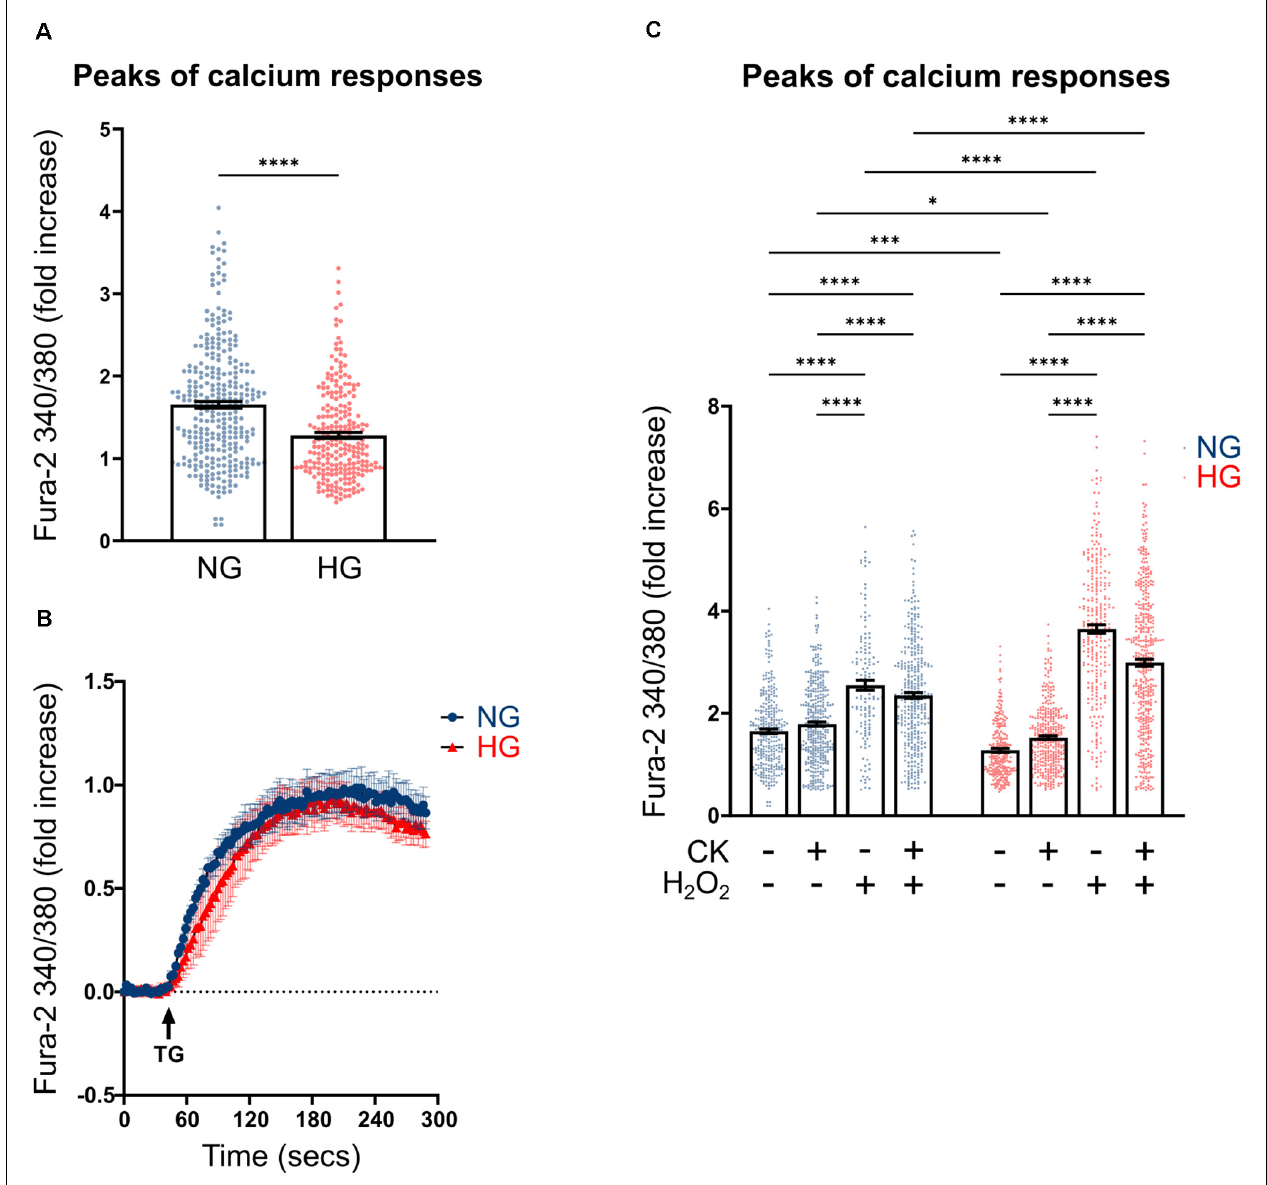
FIGURE 4 | Effect of CK treatment and oxidative stress on ATP-mediated calcium responses. (A) Scatter graph with bars represents the peaks of calcium response following ATP acute stimulation. Each dot represents the maximum peak of a single rMC-1 cell, from five separate experiments. ATP (100 µ M) was manually added to rMC-1 cells after acquiring basal Ca 2+ level images. Values are represented as a fold increase over their basal Ca 2+ level. Fold increase values are expressed as mean ± SEM. Statistical significance is calculated by the non-parametric Mann–Whitney U test ( ∗∗∗∗ p < 0.0001). (B) Kinetics of Ca 2+ response in rMC-1 cells following thapsigargin (1 µ M, TG) acute stimulation. Values are represented as a fold increase over their basal Ca 2+ level. Fold increase values are expressed as mean ± SEM of three independent experiments. (C) Scatter graph with bars represents the different peaks of calcium responses following ATP (100 µ M) acute stimulation. Each dot represents the maximum peak of a single rMC-1 cell. H 2 O 2 (300 µ M) was added 15 min before the experimental acquisition. Values are represented as a fold increase over their basal Ca 2+ level. Fold increase values are expressed as mean ± SEM of 3–5 independent experiments. Statistical significance is calculated by two-way ANOVA followed by Tukey’s post-hoc test ( ∗ p < 0.05; ∗∗∗ p < 0.001; ∗∗∗∗ p <